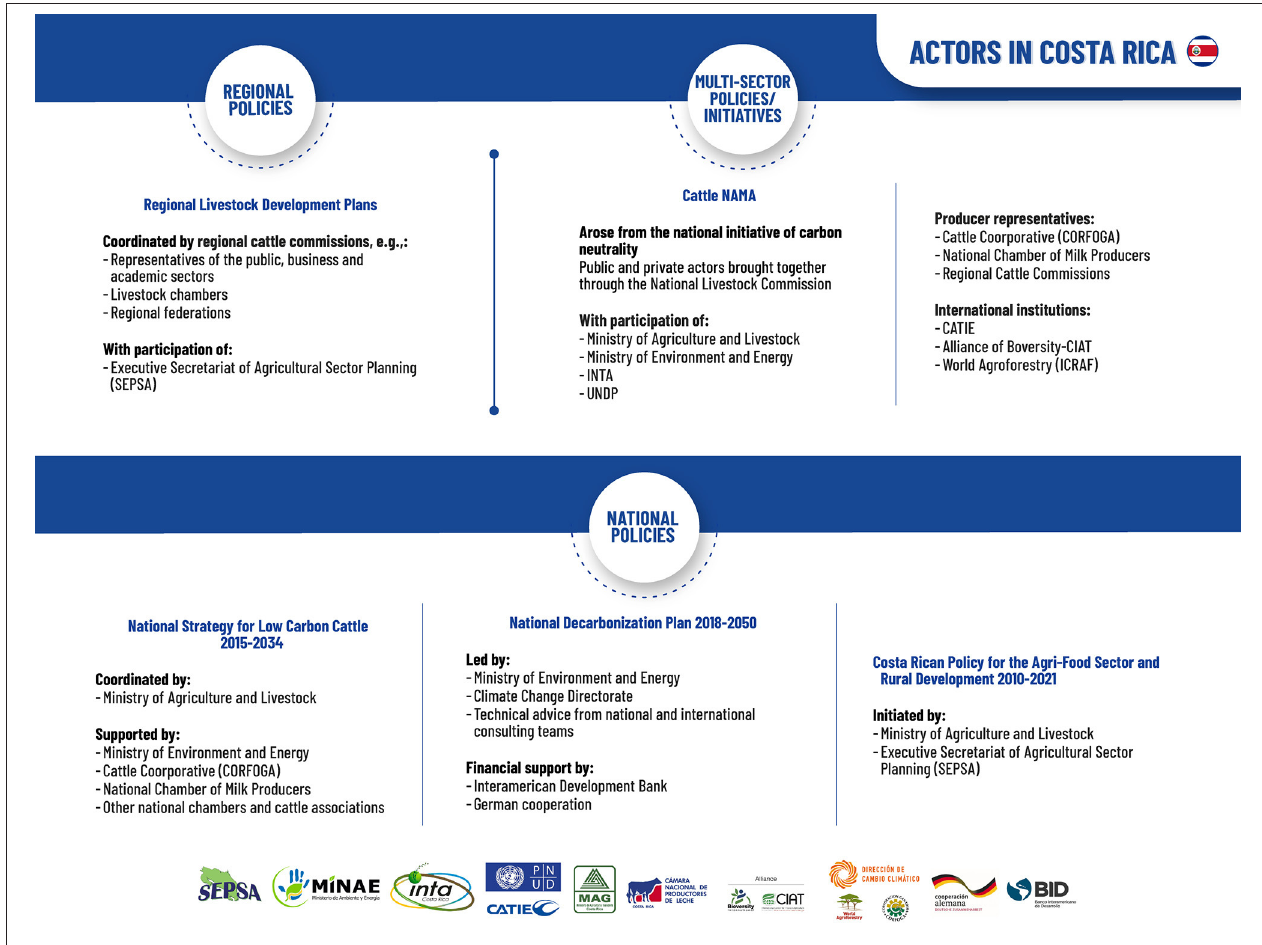
FIGURE 3 | Actors involved in the design and execution of public policies in Costa